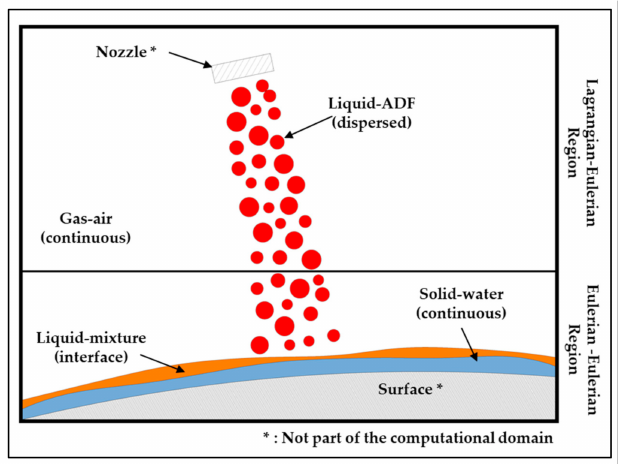
Figure 1. Typical computational domain of the proposed